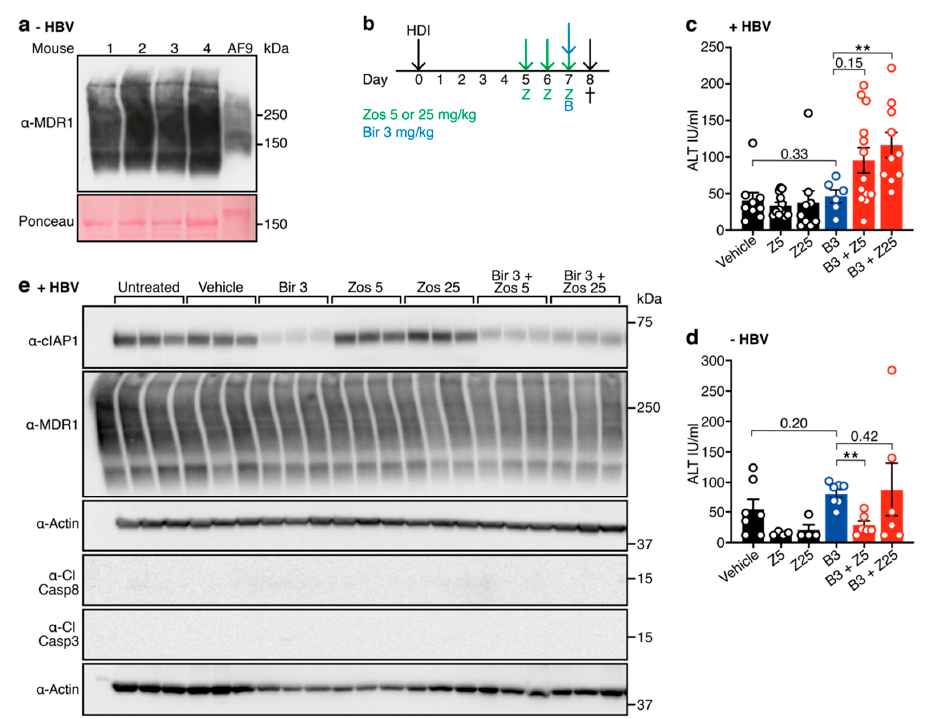
Figure 2. Birinapant in combination with zosuquidar enhances death of hepatitis B virus (HBV)-replicating hepatocytes in C57BL / 6 mice. ( a ) MDR1 is expressed in the liver of C57BL / 6 mice. AF9—murine MLL-AF9 leukemic sample as a positive control. Ponceau was used as a loading control. ( b ) C57BL / 6 mice were hydrodynamically injected (HDI) with HBV encoding plasmid (day 0) and preloaded with zosuquidar (zos) 5 mg / kg or 25 mg / kg for three days (day 5, 6 and 7) prior to ± birinapant (bir) 3 mg / kg treatment (day 7). Mice were culled ( † ) 16 h following birinapant treatment (day 8) and cardiac blood was analyzed for alanine aminotransferase (ALT) levels. ALT levels in ( c ) HBV replicating ( n = 6 − 13, 3 independent experiments) and ( d ) naïve mice ( n = 4 − 7, 2 independent experiments) treated with zosuquidar (Z) 25 mg / kg ± birinapant (B) 3 mg / kg. ( e ) Western blot analysis of total liver cell lysates from mice that replicate HBV (day 8) were probed with the indicated antibodies. Actin was used as a loading control. Cl, cleaved; Casp, caspase. Graphs show mean ± standard error of the mean (SEM); ** p < 0.01 (nonparametric Mann-Whitney